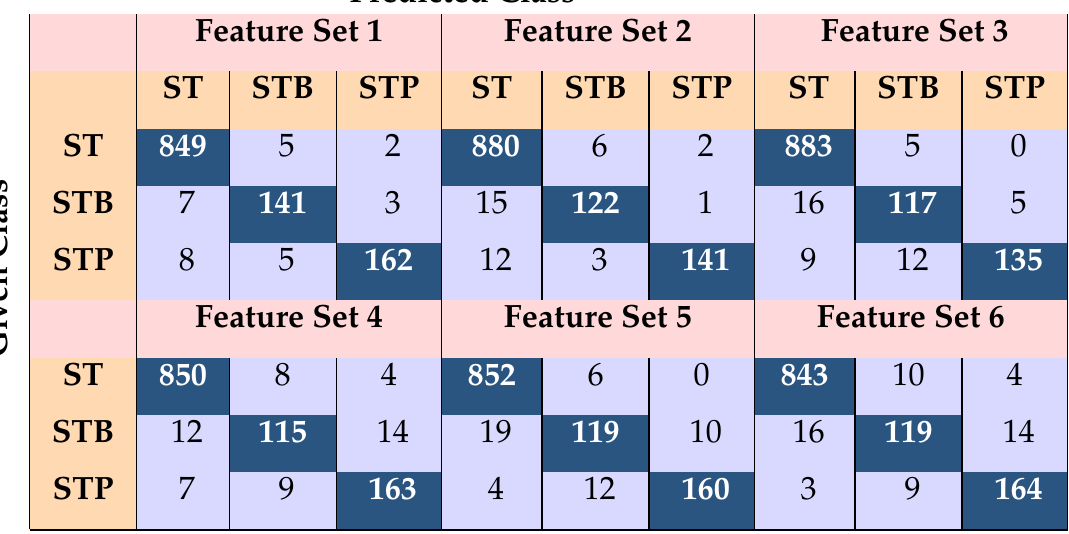
Table 7. The confusion metrics of Random Forest classifier over the 12-second window size on six feature sets at the right pant pocket (TP)